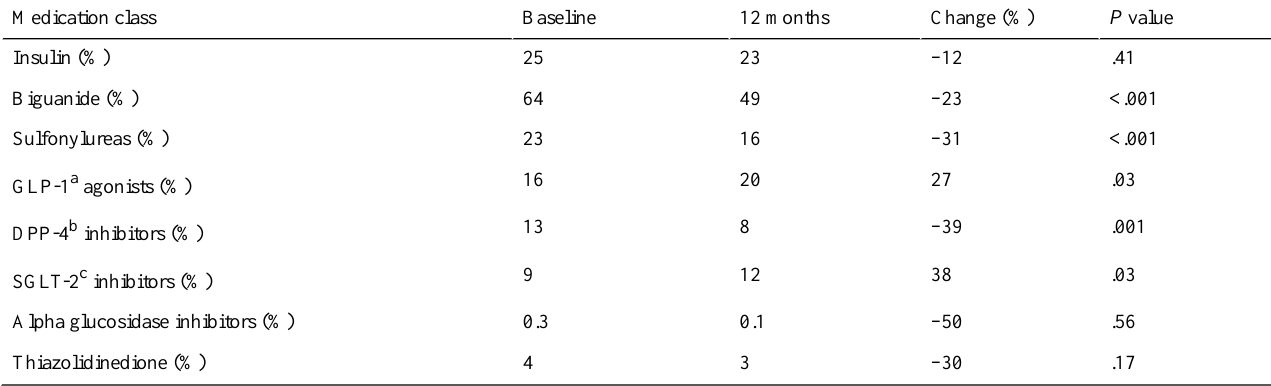
Table 7. Changes in diabetes medications over 12 months in usual